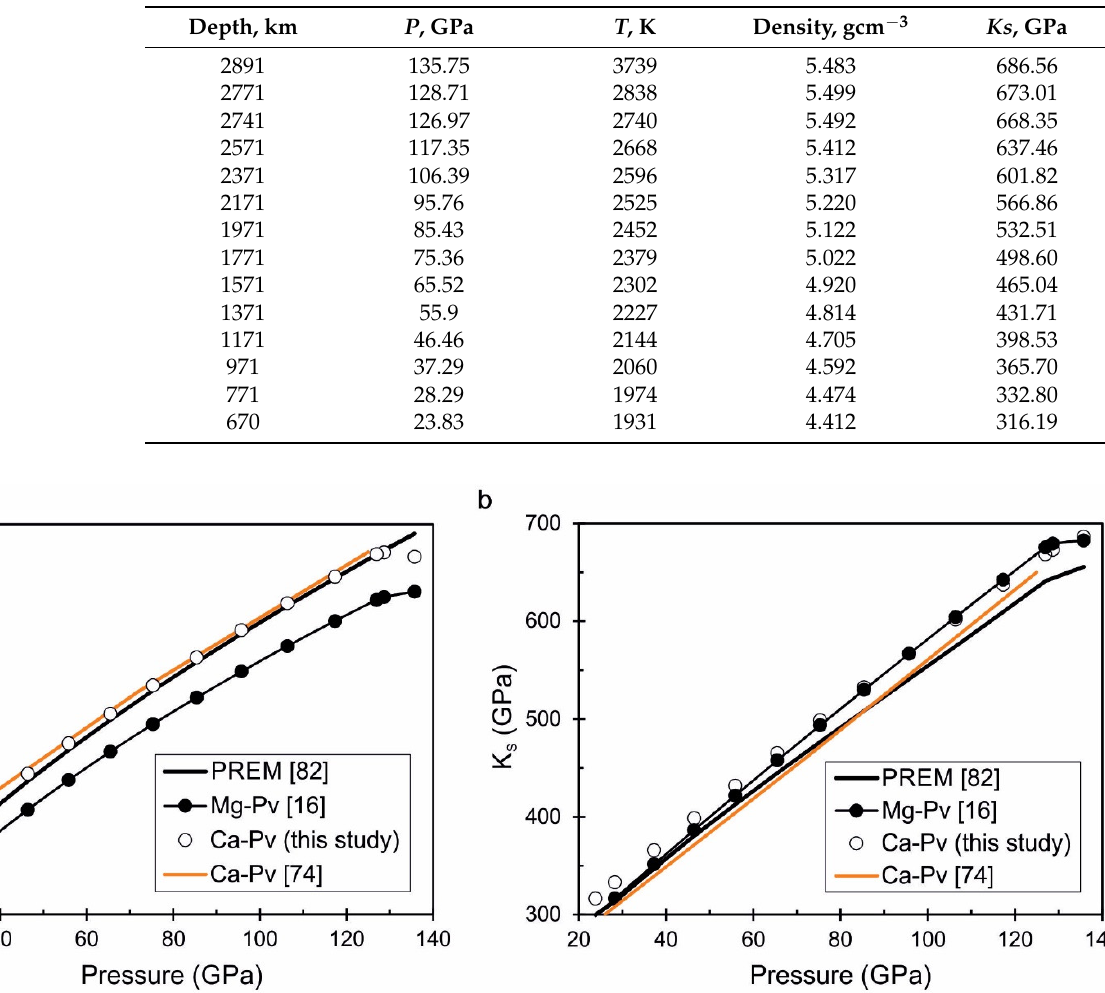
Figure 8. Densities ( a ) and adiabatic bulk moduli ( b ) of MgSiO 3 -perovskite from [16] and CaSiO 3 -perovskite from the present equation of state are calculated from the mantle geotherm in comparison with the density and adiabatic bulk modulus according to the PREM model [82] and calculation from [74].